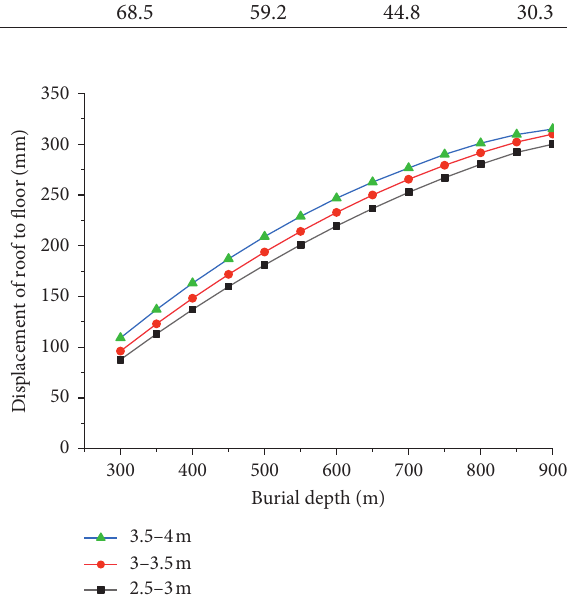
Figure 32: Displacement of roof to floor with different widths.